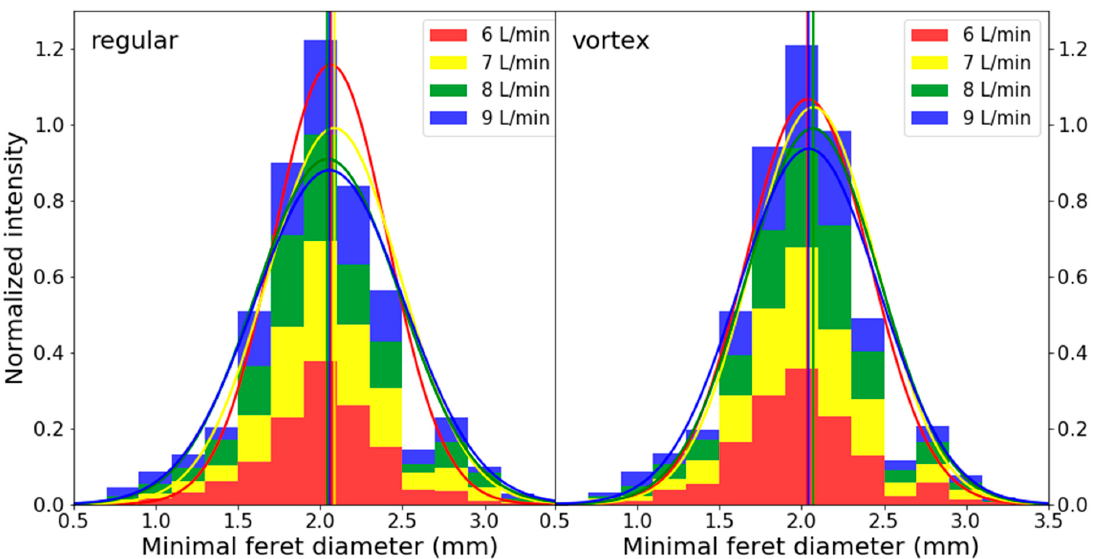
Figure 7. Minimal Feret diameter of droplets for different flow rates for regular showerhead (left) and vortex showerhead (right) at 35.8 °C. Normalized intensities (total surface is 1) and Gaussian distributions were drawn for the various flow rates, and the vertical lines indicate the means of their respective distributions.